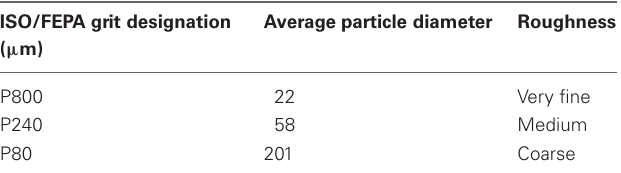
during scanning. The stimuli were fixed in the center of the